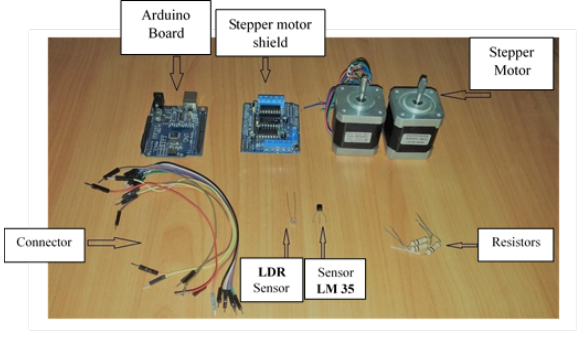
Fig. 1. Tools and materials used